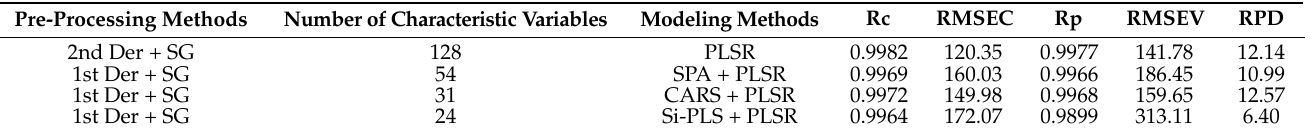
Table 6. Comprehensive comparison of the best prediction models from different algorithms for determining the available nitrogen content of a vermiculite